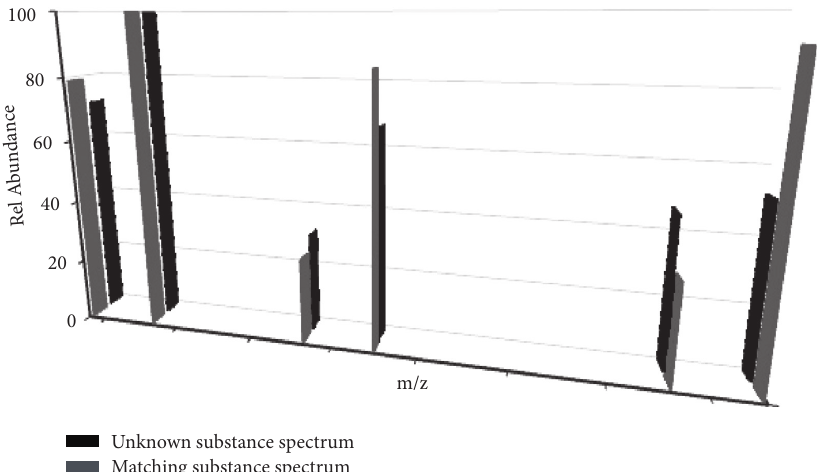
Figure 4: Detailed comparison page of screening results (3D histogram). In the 3D histogram, the x -axis represents m/z, the y -axis represents the matched substance and the unknown substance, and the z -axis represents the relative peak intensity.